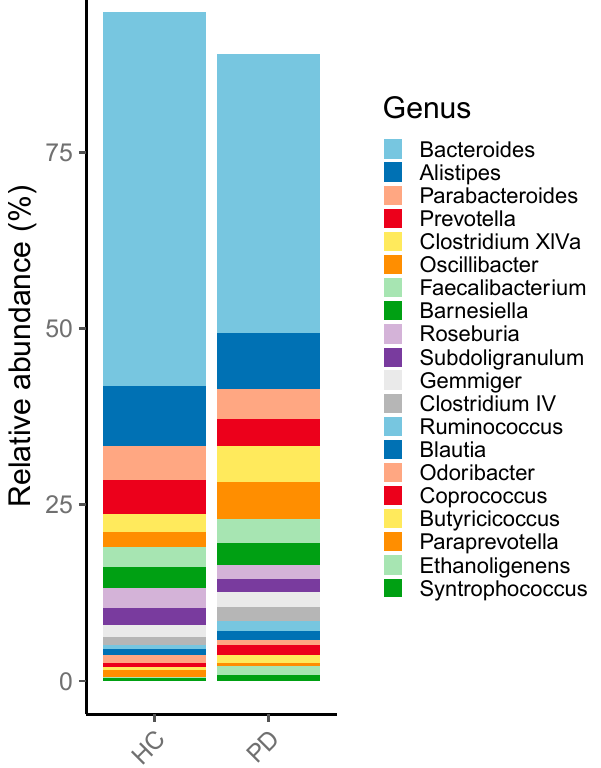
Figure 3. Relative abundance of the genus level in patients with Parkinson disease and healthy controls. HC: Healthy Controls; PD: Parkinson Disease.